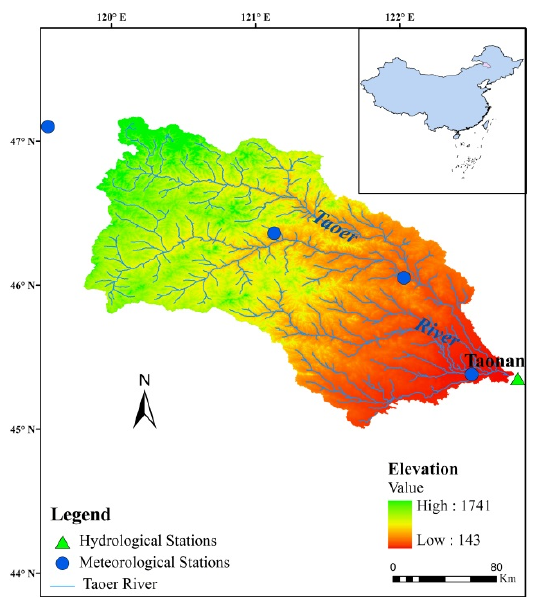
Figure 1. The location of the Taoer River basin, China. Meteorological stations ( ● ) and the hydrological station ( ▲ ) are also shown.